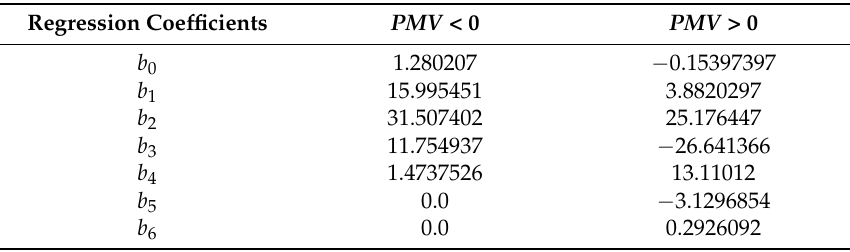
Table 4. The values of the regression coefficients, b 0 – b 6 , in Equation